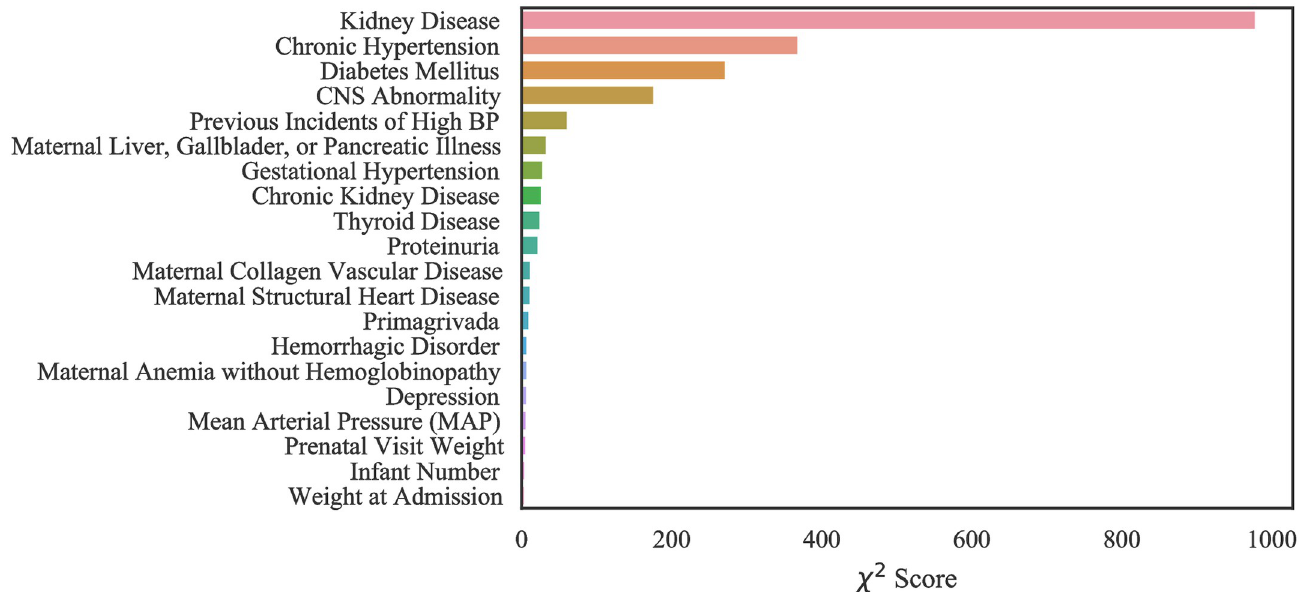
Fig 17. Feature ranking for the MOMI African American dataset.